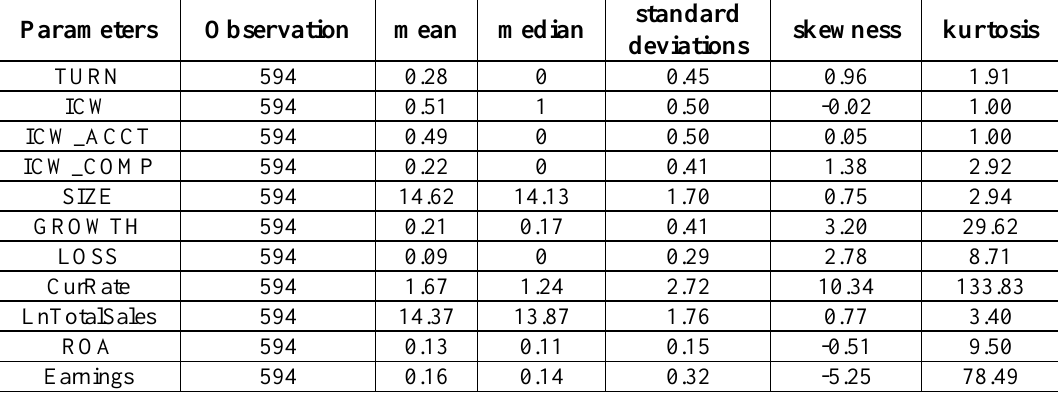
Table 2. Descriptive statistics of research